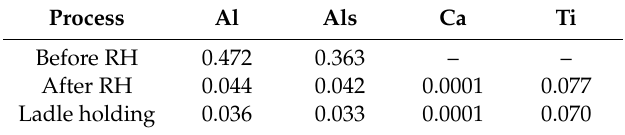
Table 2. The average chemical compositions of Al, Ti, and Ca elements in the steel, wt% Process Al Als Ca Ti Before RH 0.472 0.363 – – After RH 0.044 0.042 0.0001 0.077 Ladle holding 0.036 0.033 0.0001 0.070